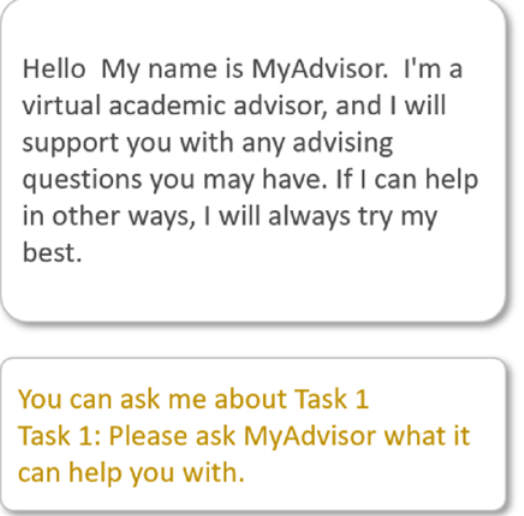
Figure 1. The chatbot greets the students and invites them to ask a question.